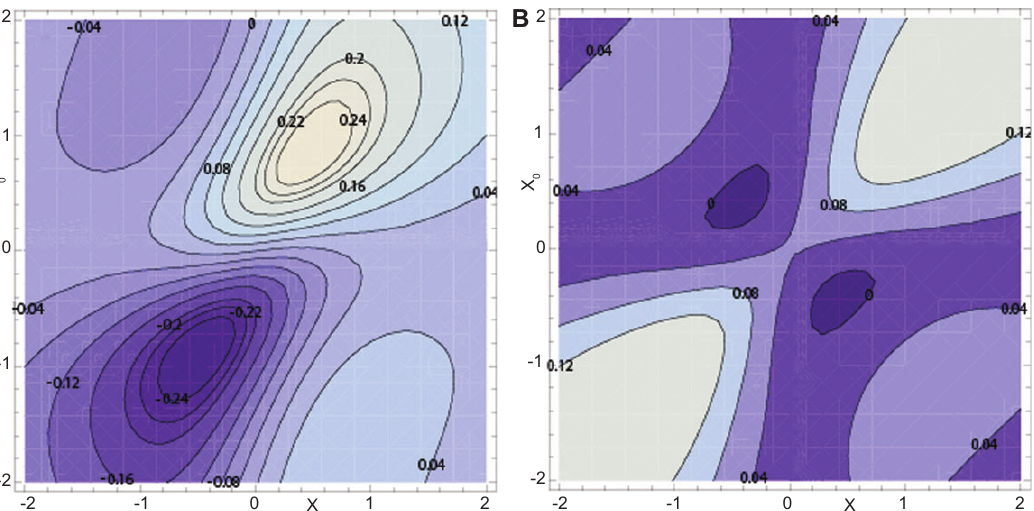
*( ) T u *( ) T v (A) and tangential (B) surface displacements due to the hole under the action of the α = α = 0 0 is a coordinate of applied force. The linear quantities are 0 ( 2 ) where f is a value of the applied tan- T